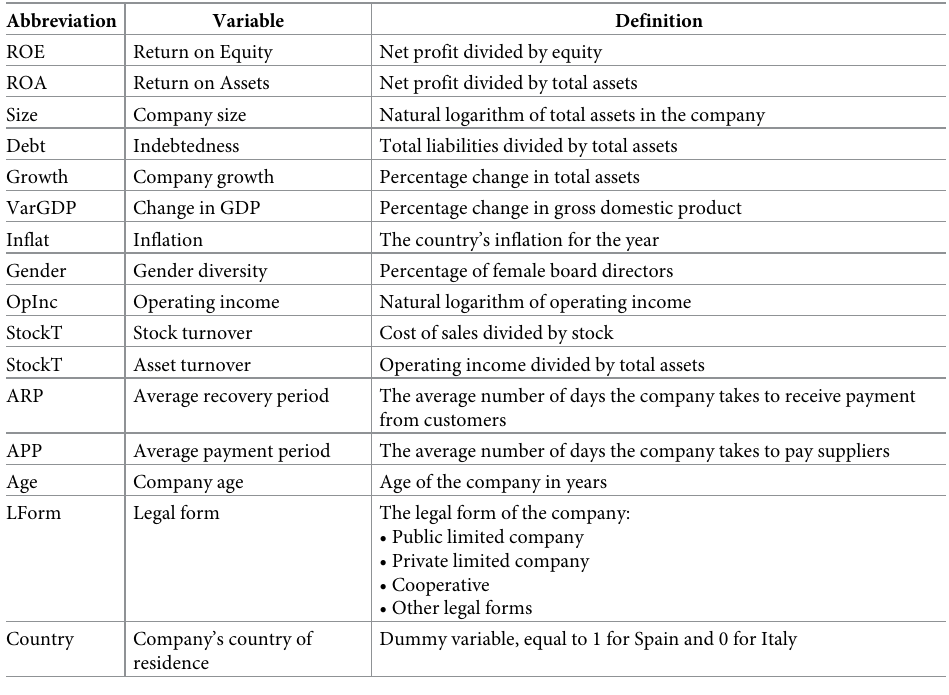
Table 1. Definition of